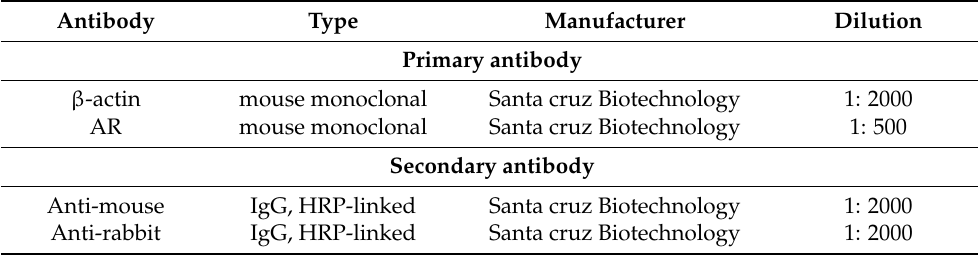
Table 6. List of used